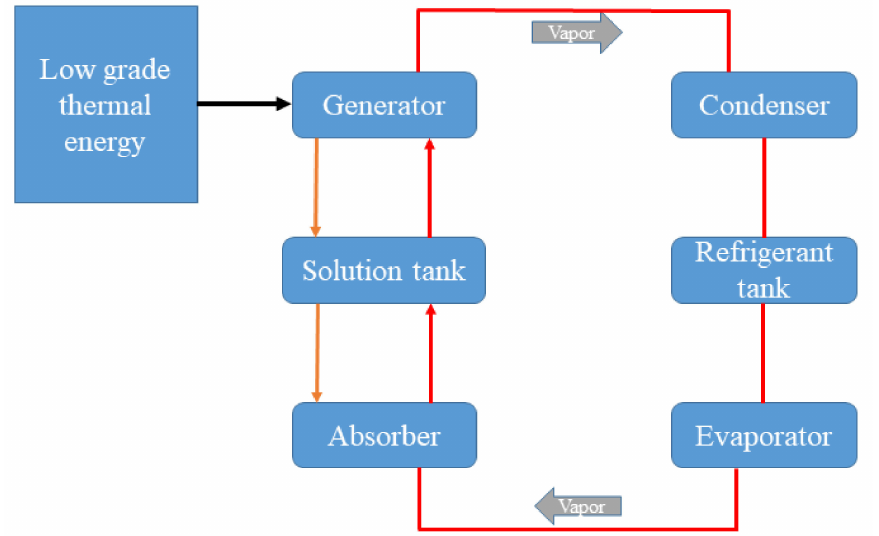
Figure 11. Single-stage absorption TES